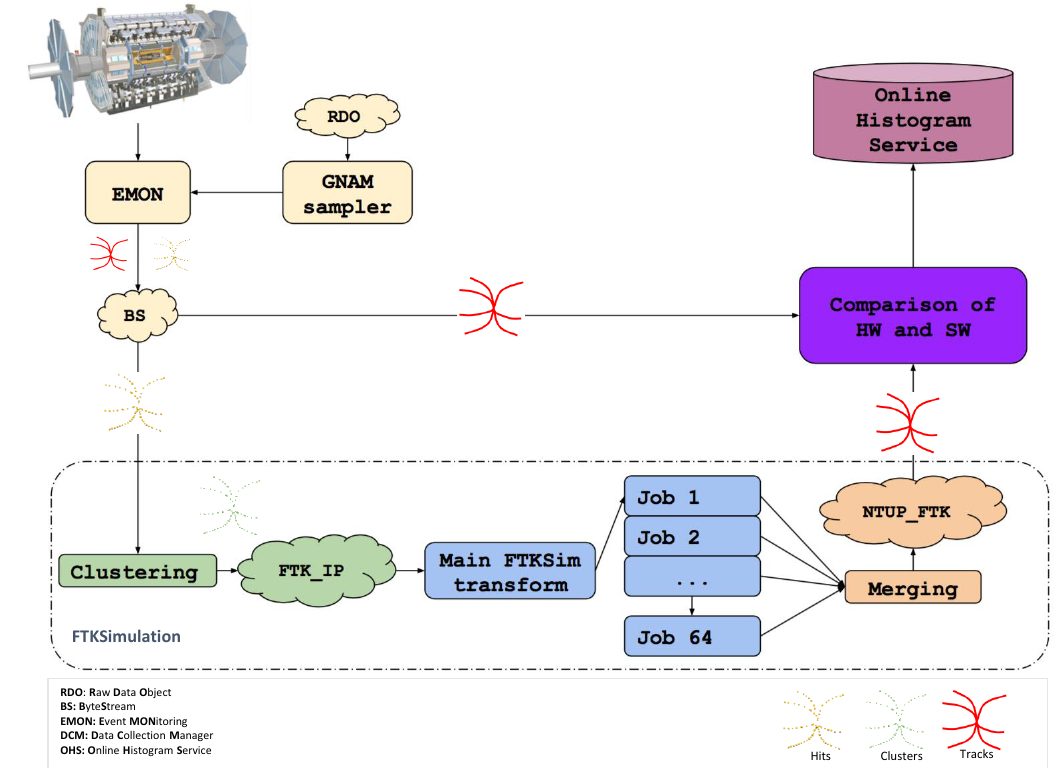
Figure 6. Layout of the High-Level Data Quality Monitoring